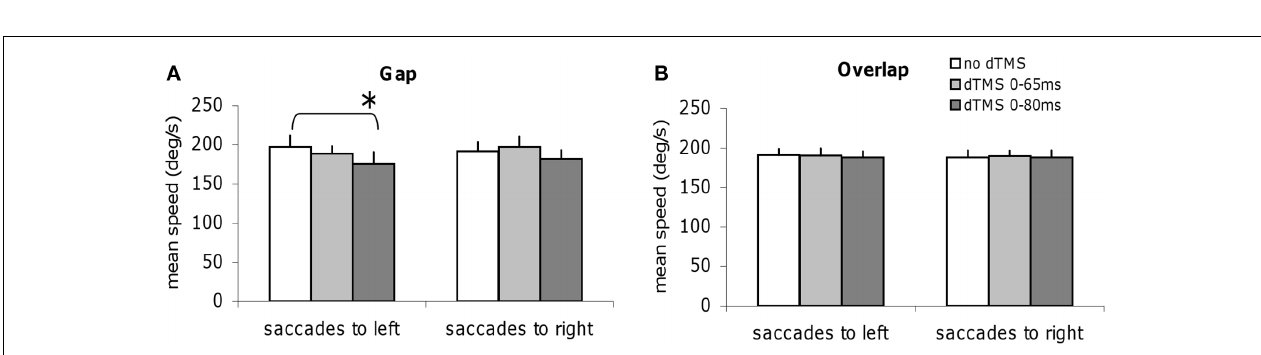
FIGURE 6 | Group mean speed with SE of saccades for saccades to left or to right in different dTMS conditions: no dTMS, dTMS 0–65ms, dTMS 0–80ms under the tasks gap (A) and overlap (B). Asterisks indicate a significant effect on group mean speed of dTMS with an ISI of 65 or 80ms versus control no